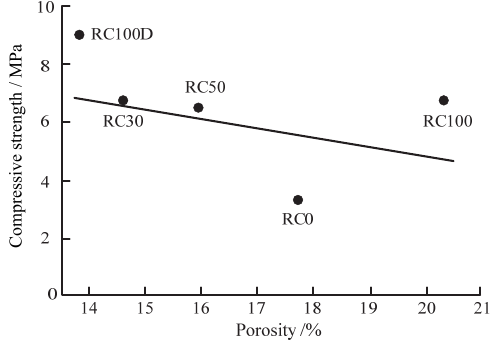
Figure 5: Porosity and compressive